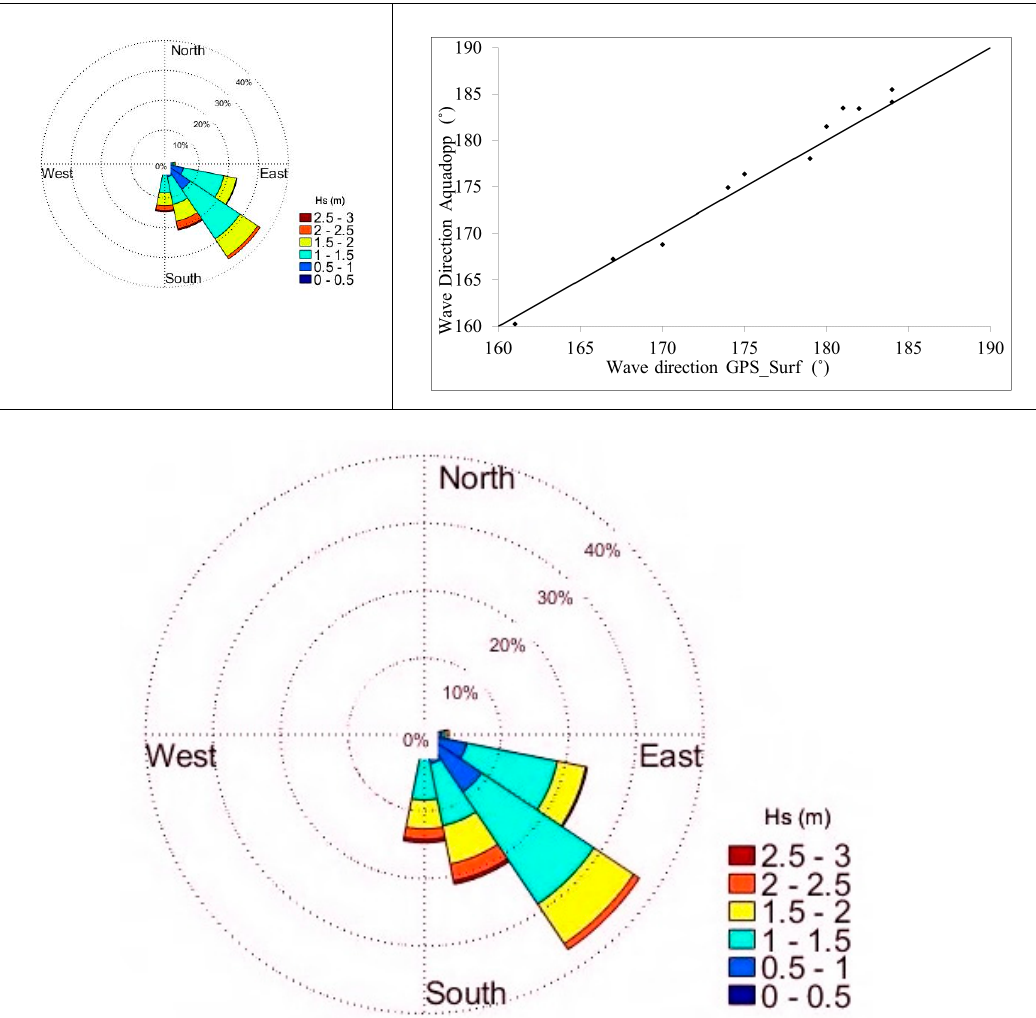
Figure 3. Wave rose (60-m depth) and relation between the wave direction measured by the Aquadopp and the GPS_Surf near the coast. The R-squared value is 0.98.